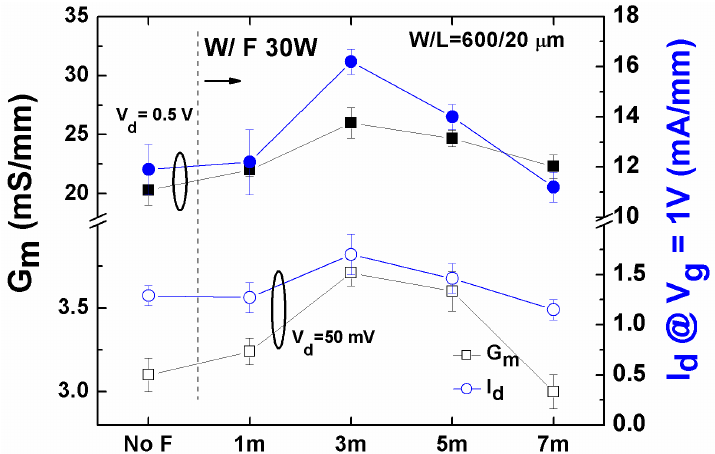
and I as a function of CF m d = 50 mV and 0.5 V). RF power: 30 W. d